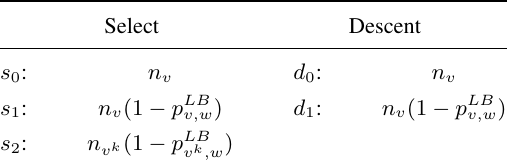
Table 2. Different strategies for calculating probabilities to select nodes and descend to leafs. s 0 and d 0 are equivalent to random sampling, the others are active learning